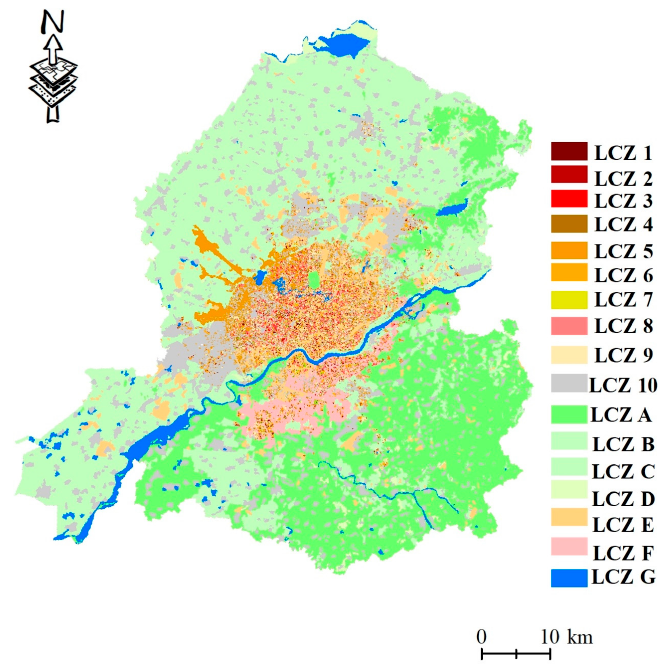
Figure 7. LCZ division results and the number of each type.